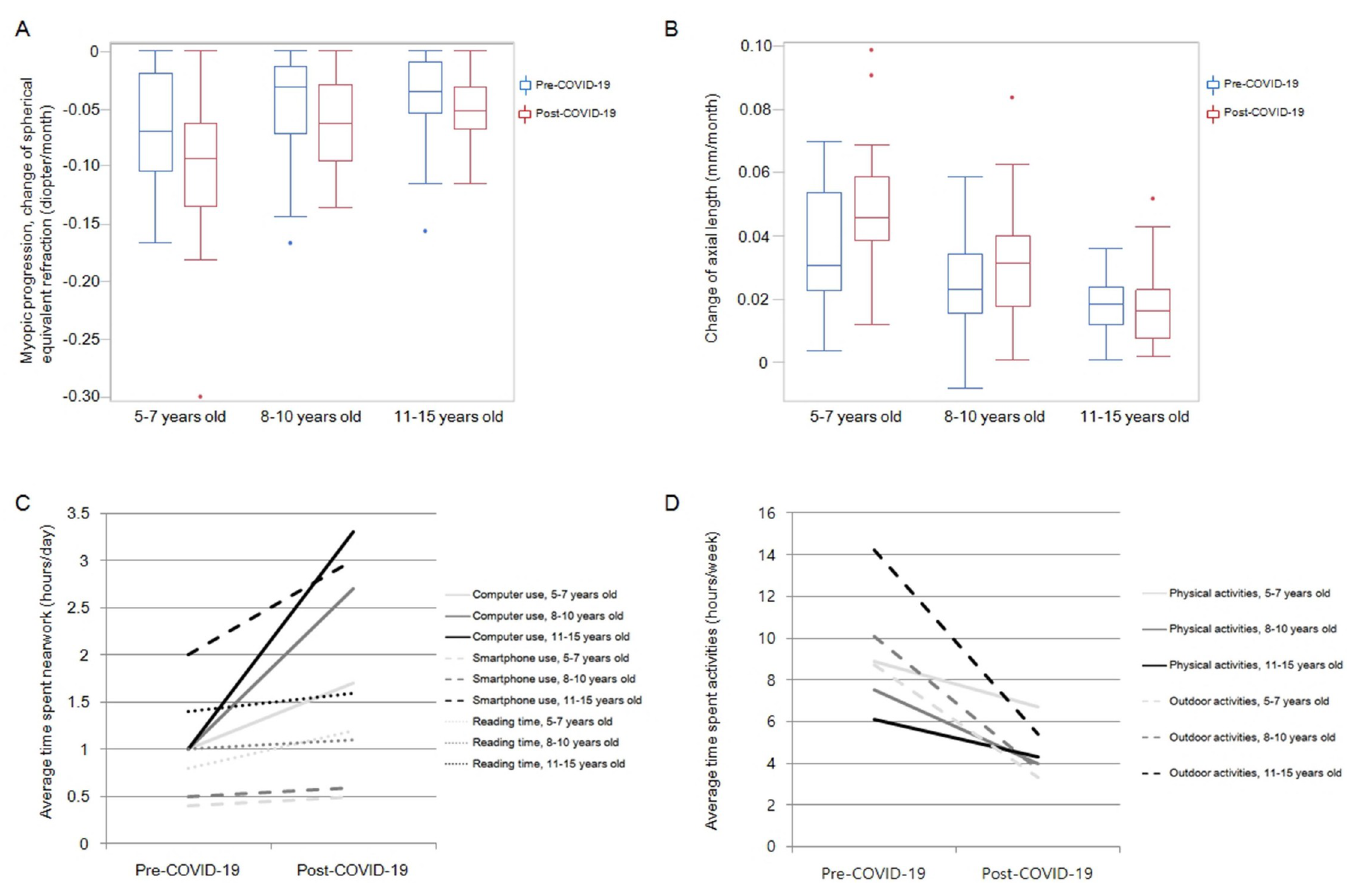
Fig 1. Changes of refractive error, axial length, and questionnaire before and after coronavirus disease 2019 according to children’s age.